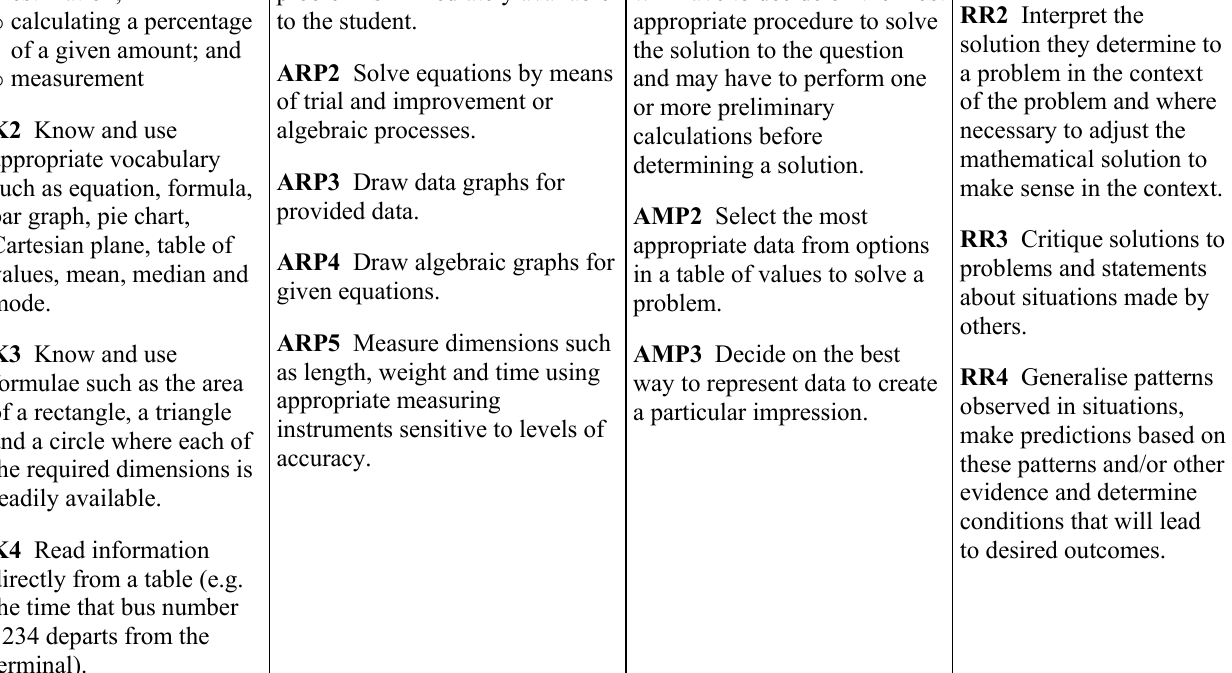
Figure 1: Description of the Mathematical Literacy assessment taxonomy